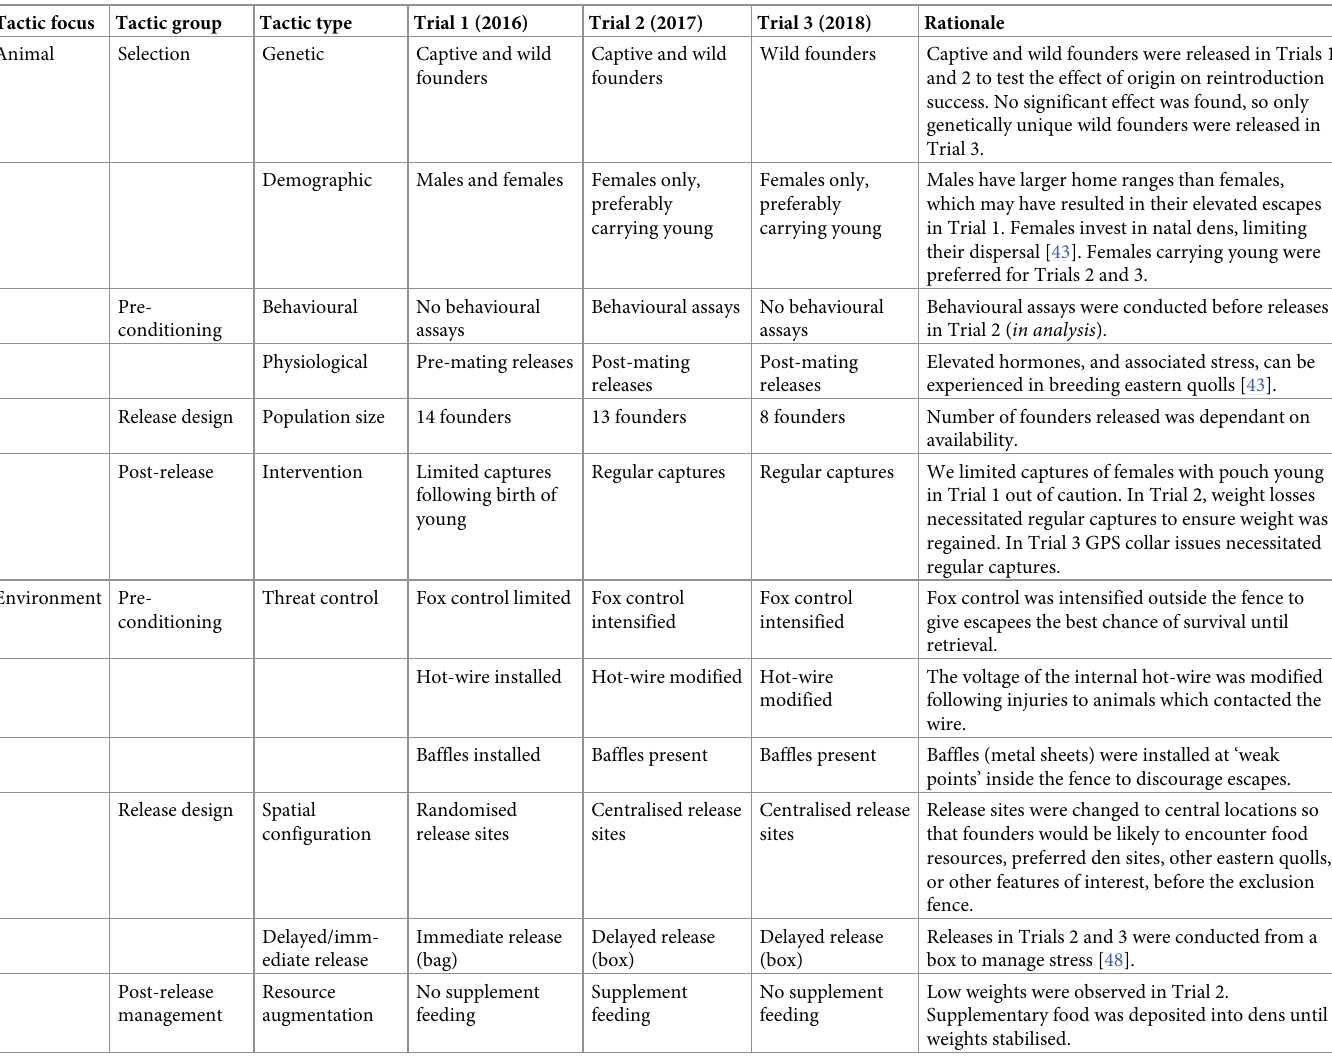
Table 1. Tactics employed for three trial reintroductions of the eastern quoll ( Dasyurus viverrinus ) to Mulligans Flat Woodland Sanctuary, ACT Australia from 2016–18. Tactics were organised as per the Translocation Tactics Classification System (Fig 1, Batson et al . 2015). Tactic focus Tactic